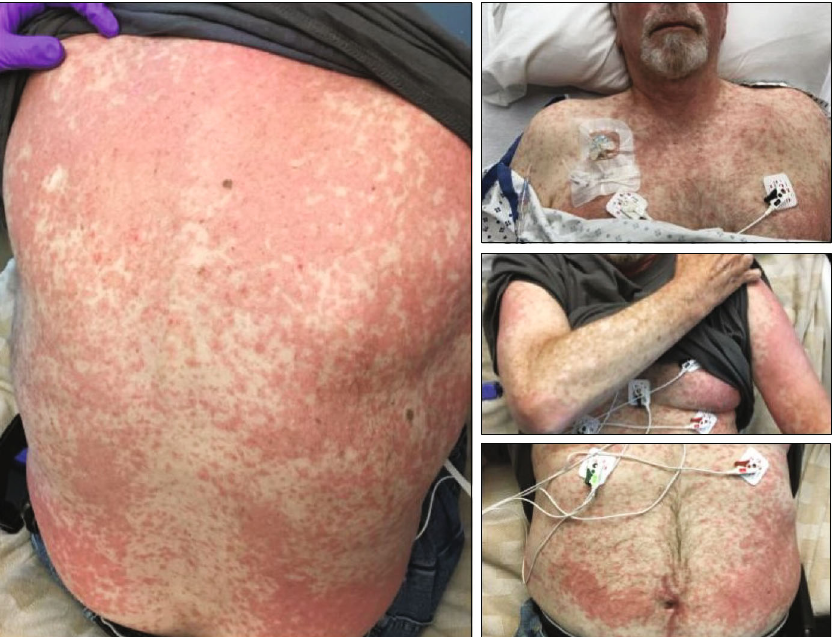
Figure 3: Generalized pruritic and con fl uent morbilliform rash involving the face, neck, chest, back, abdomen, arms, thighs, and lower legs. Erythema and mild edema on the cheek, ears, and neck.